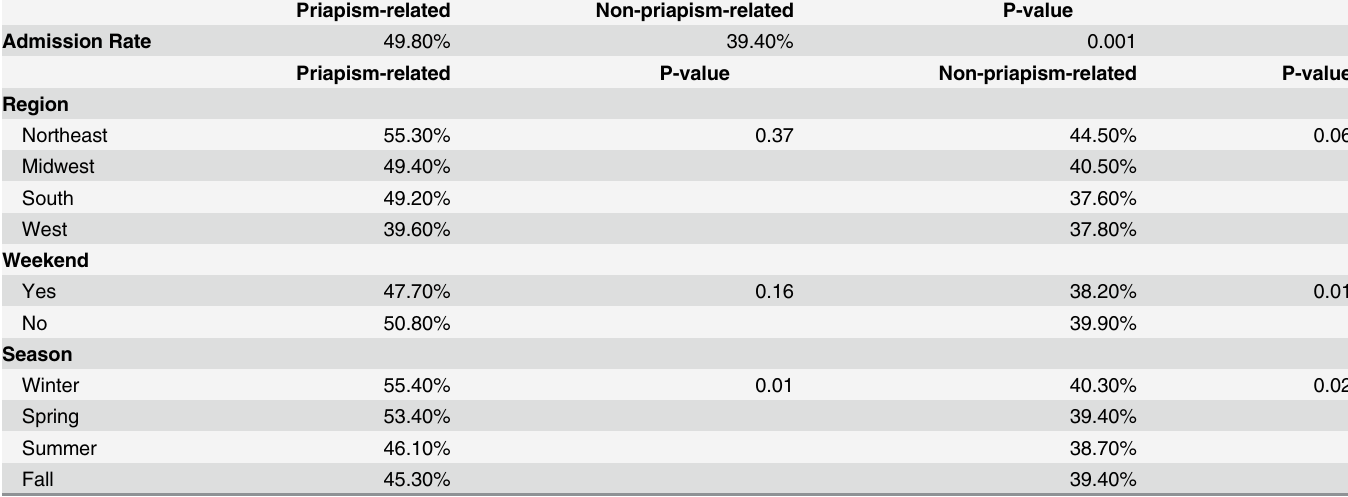
Table 2. Admission rates from sickle cell disease-related emergency department visits with and without priapism by